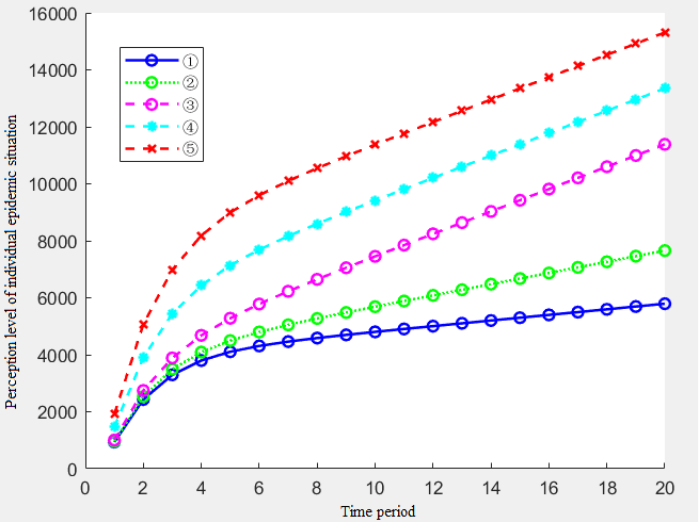
Figure 7. Changes of the epidemic perception when the amount of information stimulus showed an increasing trend.